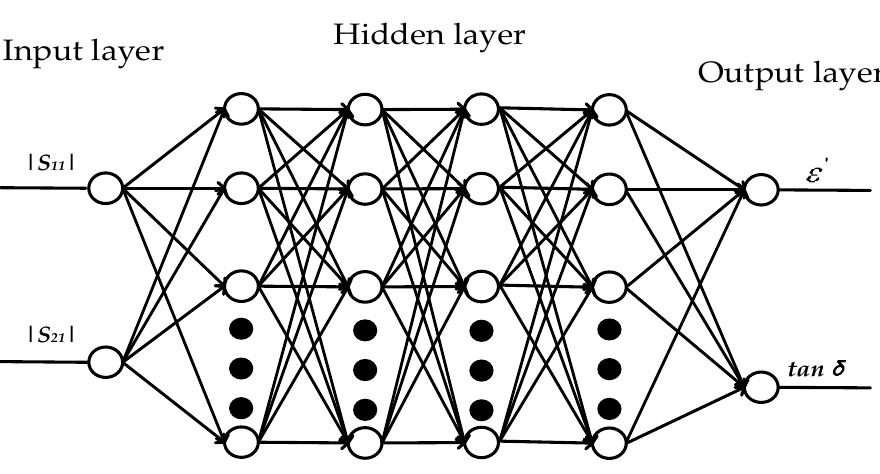
Figure 4. Sensitivity comparison results of oblique aperture ridge waveguide and normal ridge waveguide at tan δ = 0.8: ( a ) Sensitivity comparison results of | S 11 |; ( b ) sensitivity comparison results of | S 21 |.